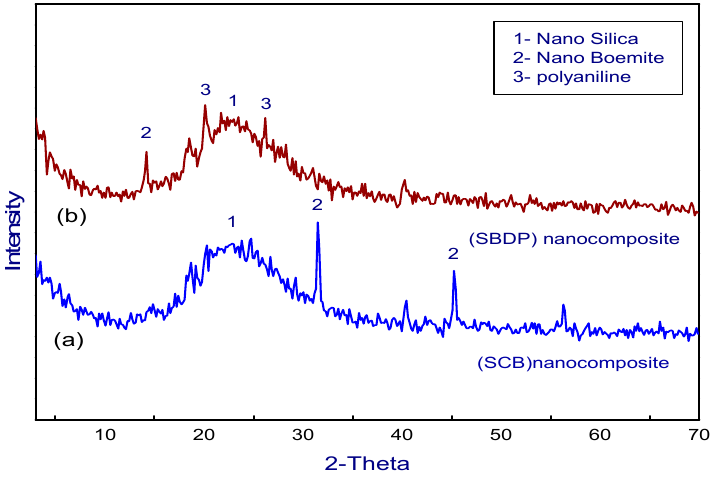
Figure 2. XRD pattern of ( a ) SCB, ( b ) SBDP nanocomposite